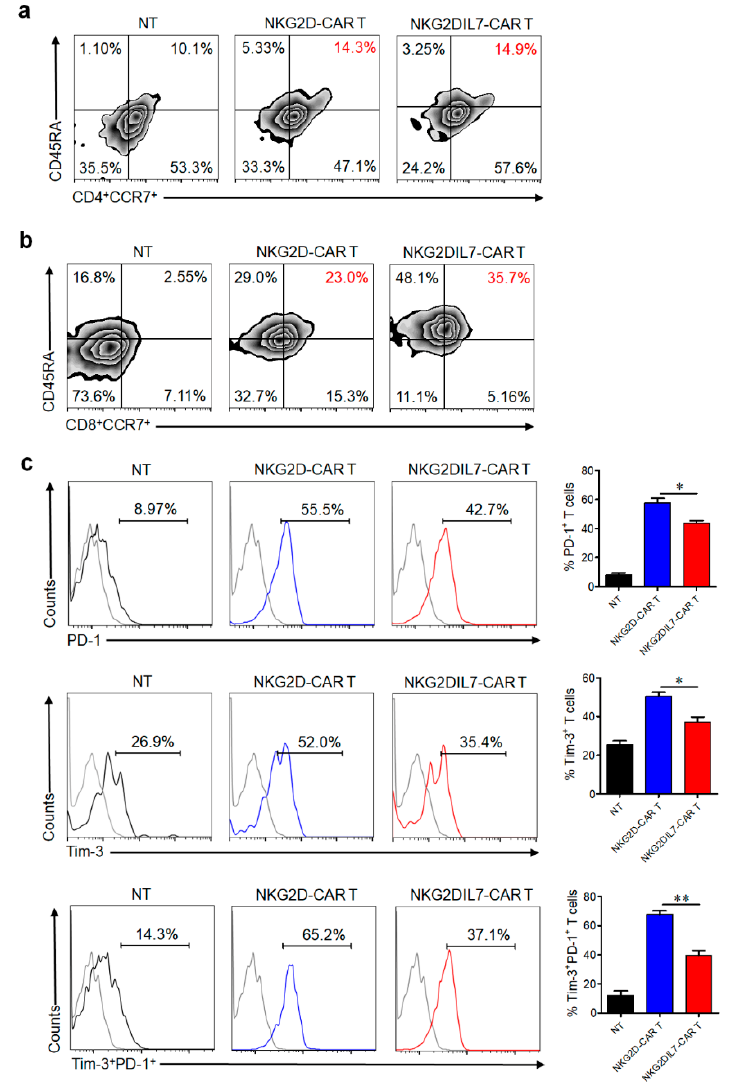
Figure 4. IL-7 increases CAR T cells with the less differentiated phenotype and inhibits CAR T-cell exhaustion. a, b T-cell phenotype based on CD45RA and CCR7 expression in CD4 + ( a ) and CD8 + ( b ) CAR T cells was analyzed by FACS after 14 days of culture. c , Surface expression of PD-1 and Tim-3 on CAR T cells was analyzed by FACS after 7 days of co-culture with tumor cells. * p < 0.05, ** p < 0.01. Data are representative of four T-cell lines.